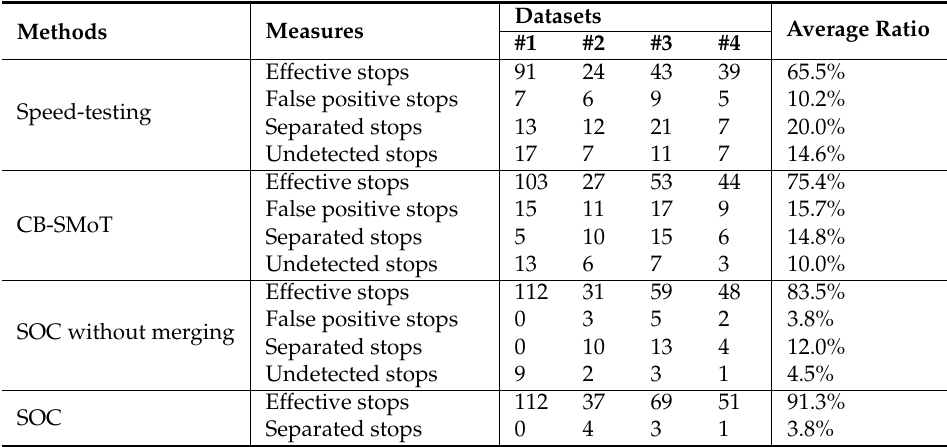
Table 4. SOC versus two baseline methods on detecting